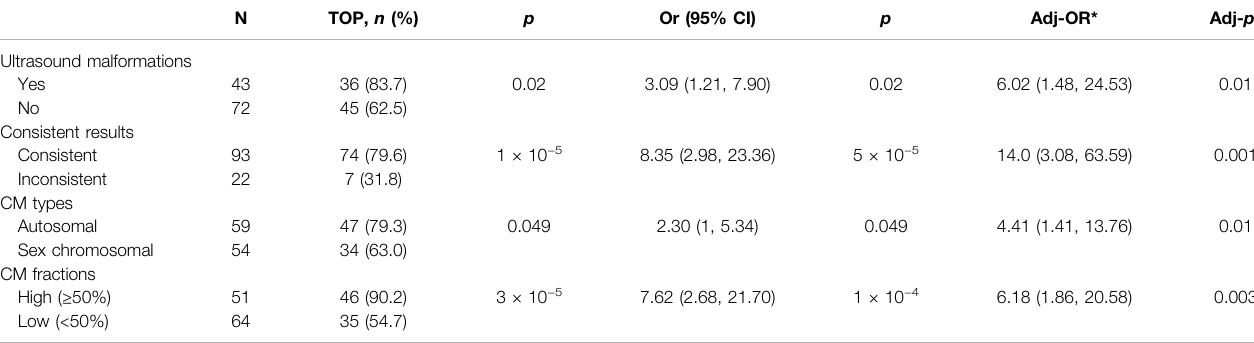
TABLE 4 | Effect of ultrasound features, CM types, CM fractions, and consistent or inconsistent results on pregnancy